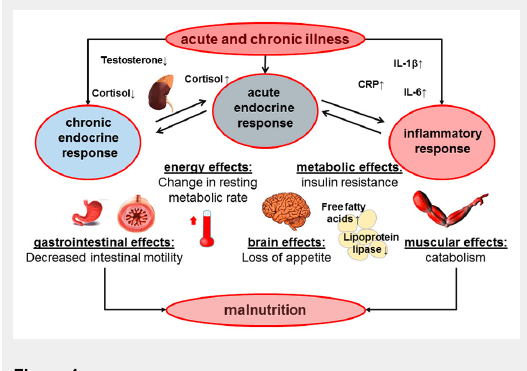
Summary of physiopathological mechanisms occurring during acute and chronic illnesses including endocrine and inflammatory pathways leading to malnutrition. CRP = C-reactive protein; IL =